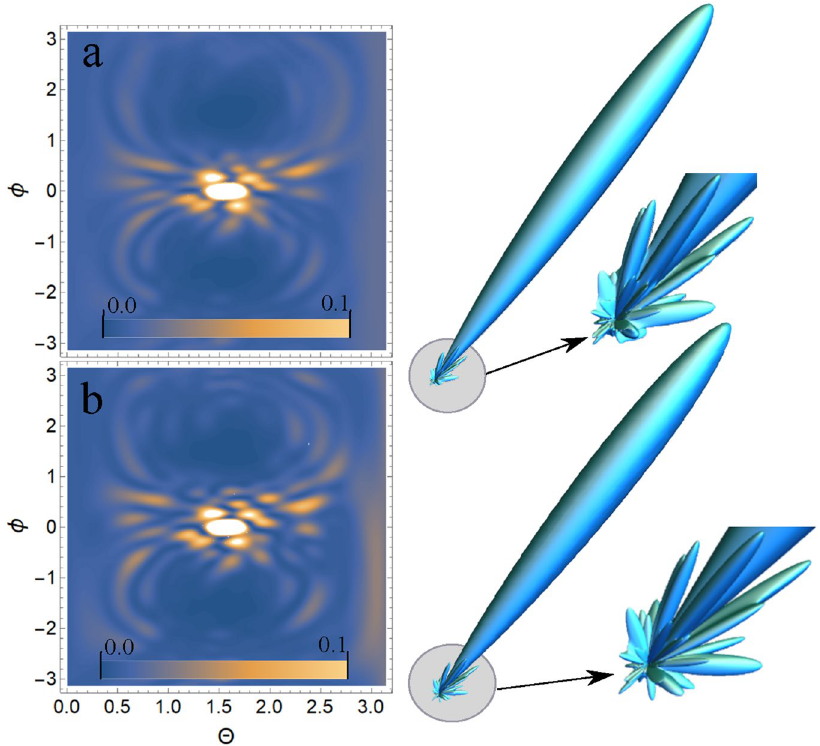
Figure 7. Scattering spectra of USP on thymine are presented. The rest is the same as on Fig. 3.